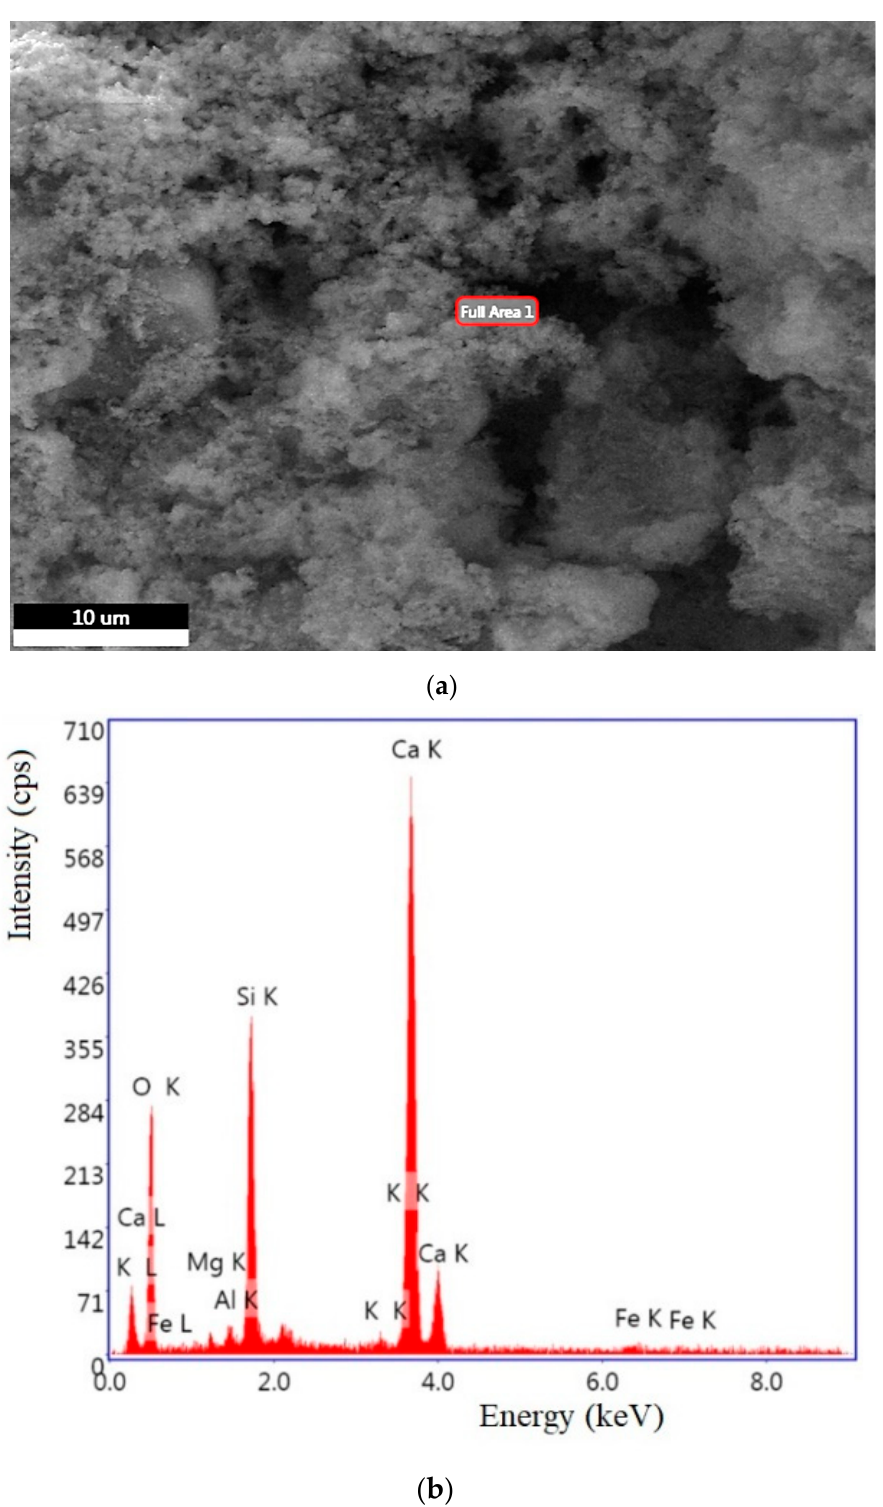
Figure 9. Scanning electron microscopy image ( a ) associated with EDX analysis ( b ) for sample A.